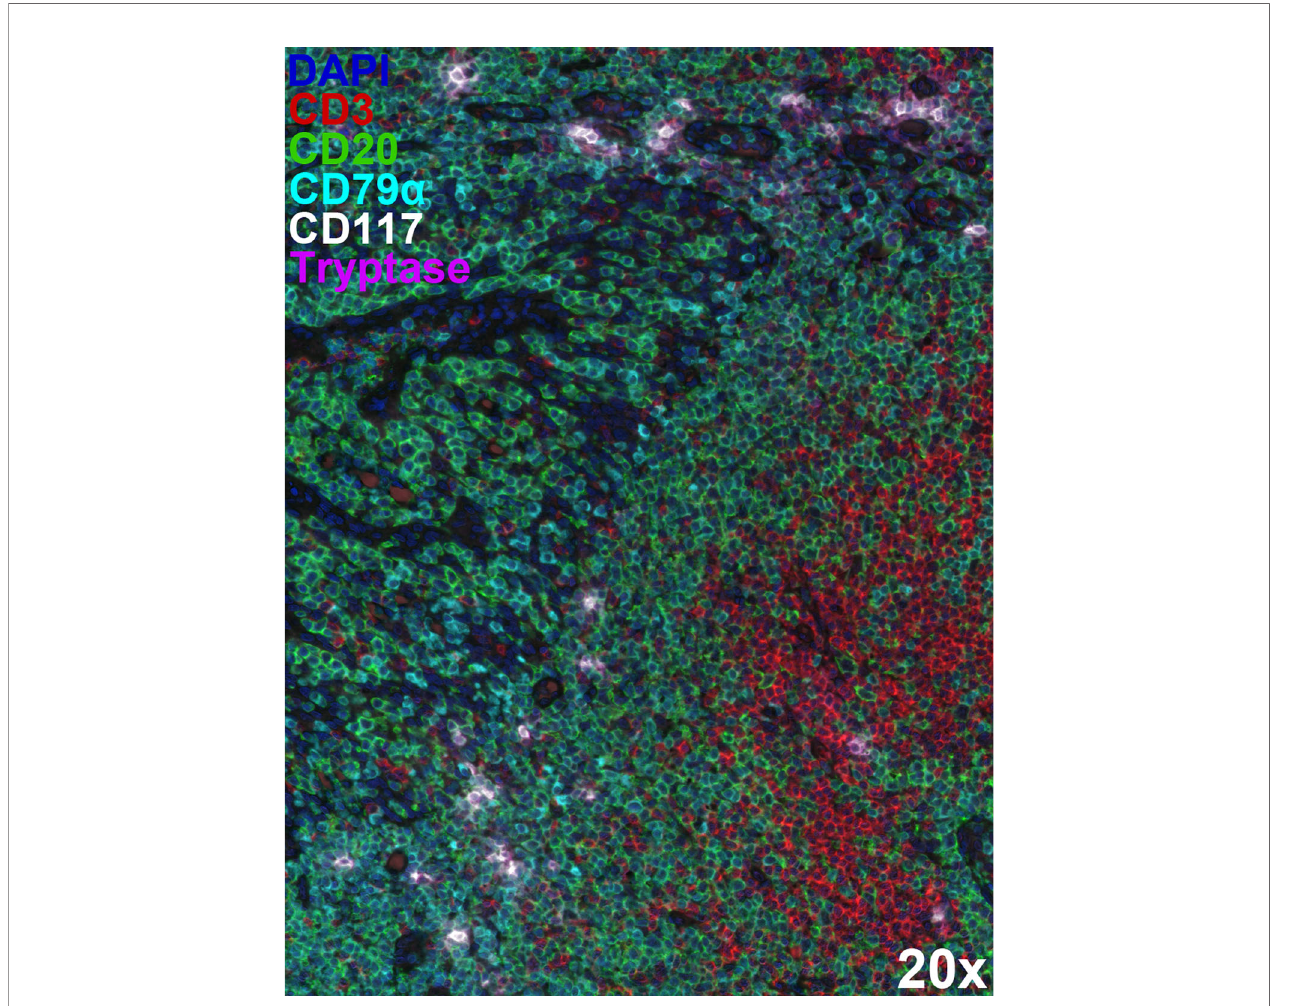
FIGURE 2 | Extensive mast cell/B cell co-localisation within lymphoid tissue. Multiplex immunostaining using Opal ™ technology (Akoya Biosciences) identi fi ed CD20 + CD79 a + B cells (green and cyan), tryptase + CD117 + mast cells (magenta and white), and CD20 - CD3 + T cells (red) within formalin- fi xed, paraf fi n-embedded 5 µm-thick human tonsil sections. The 6-plex panel (including DAPI counterstaining) scans were acquired on the Mantra 2 ™ Quantitative Pathology Workstation using pre-de fi ned parameters at 20x original magni fi cation and spectrally unmixed using inForm ® software (Akoya Biosciences). Representative image illustrating close- proximity between mast cells and B cells within tonsil architecture. Mast cells appear less in T cell dense